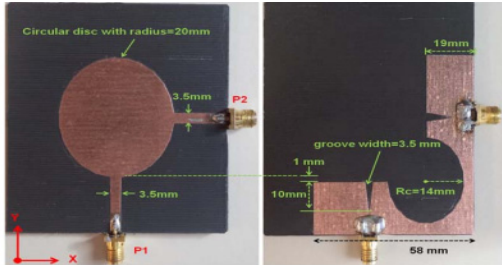
Figure 7. Shared radiator with circular cut at ground [63].